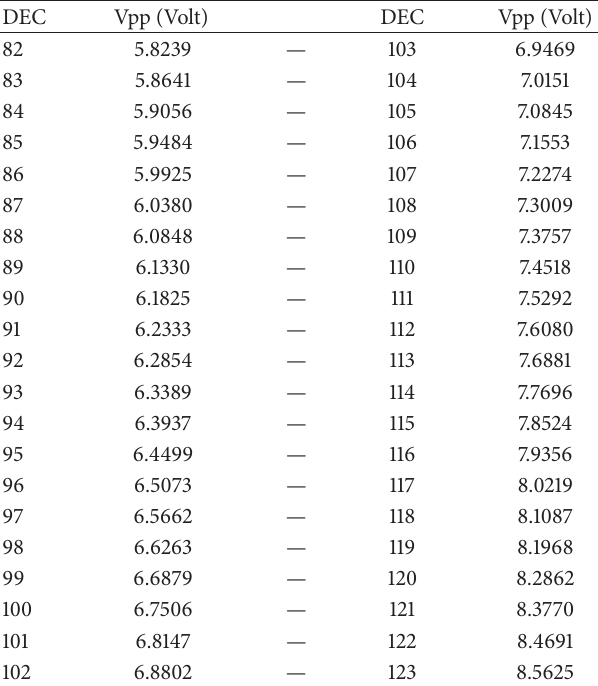
Table 1: DEC-Vpp valued correspondences.